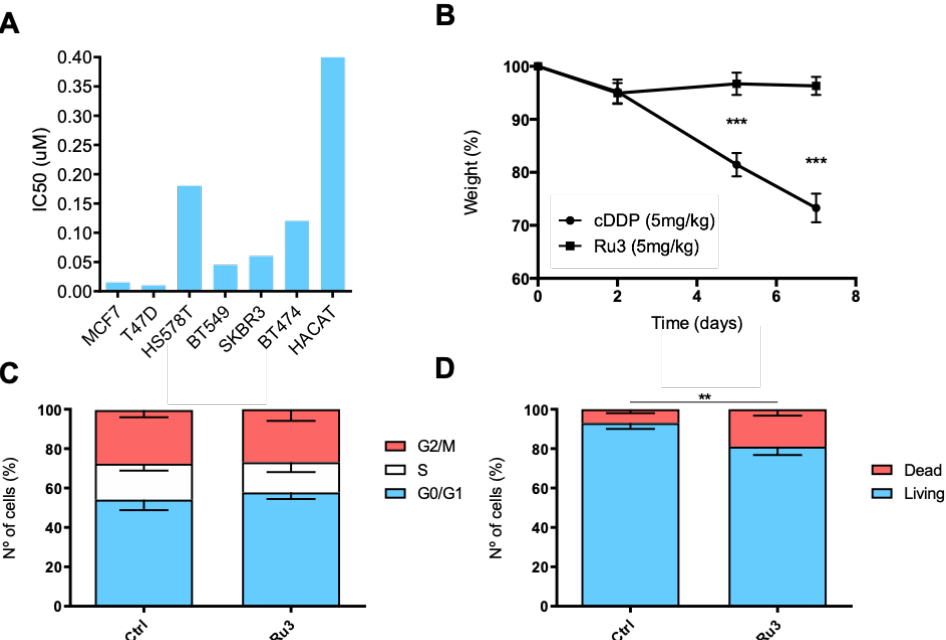
Figure 7. Ru3 displays less toxicity in non-transformed cells. ( A ) IC 50 comparison, measured by MTT metabolization, between breast cancer cell lines and HACAT, showing that the IC 50 of the non-transformed cell line at least doubles the value of the transformed cell lines. ( B ) Ru3 shows lower toxicity in vivo than platin compounds. Toxicity was evaluated after 7 days of IP treatment with 5 mg kg − 1 twice a week. Ru3 (N = 6) exerted significantly less toxicity than cDDP (N = 6) at the 5 mg kg − 1 with a treatment schedule of two administrations a week. ( C ) The effect of Ru3 in HACAT cell lines in terms of cell cycle arrest, demonstrating no modifications in any cell cycle phase. ( D ) Cell death was evaluated, and weaker effects were observed when compared to breast cancer cell lines at the dose of 200 nM. Data are the average +/ − standard deviation (SD) of three independent experiments performed in triplicate. To determine significant statistical differences between the averages of treatment groups, G0/G1 or living cells groups respectively, Student’s t -test was used. The values for the statistical analyses are: *, p ≤ 0.05; **, p ≤ 0.01; ***, p ≤ 0.001.